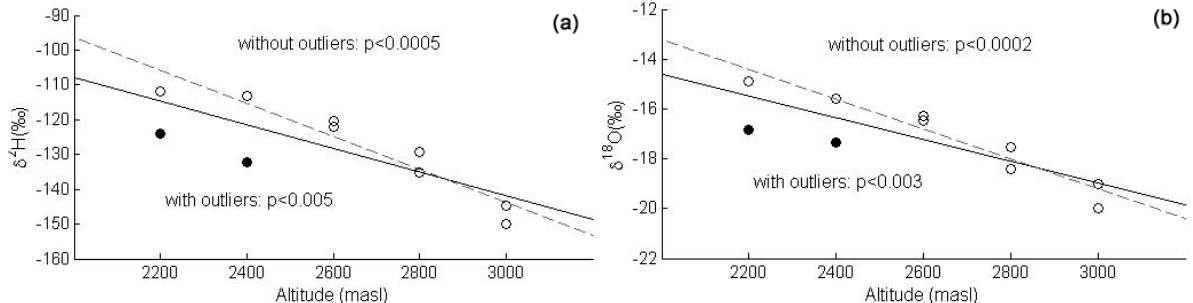
Fig. 6. (a–b) Relationship between δ 2 H (a) and δ 18 O (b) and altitude of snow-cores collected along an elevation gradient (2200–3000ma.s.l.), along the road to the Chile–Argentina border, just northeast of the studied catchment ( δ 2 H = 0.0342 · elevation − 39.48